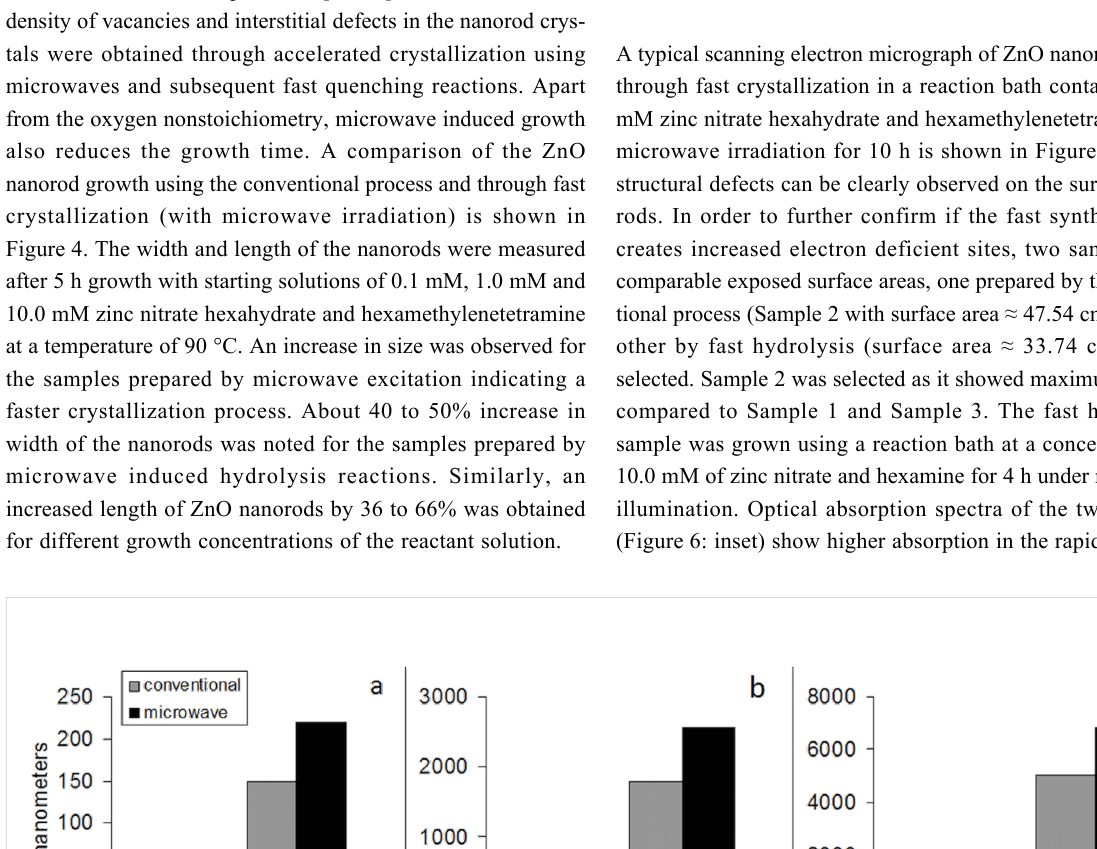
Figure 4: Increase in width and length resulting from fast crystallization by the use of microwave irradiation after 10 h growth at different growth concentrations: (a) 0.1 mM, (b) 1.0 mM, and (c) 10.0 mM.